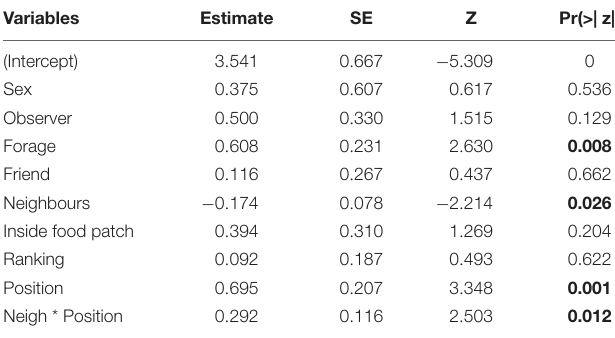
TABLE 1 | Results of the final model for the observational data.